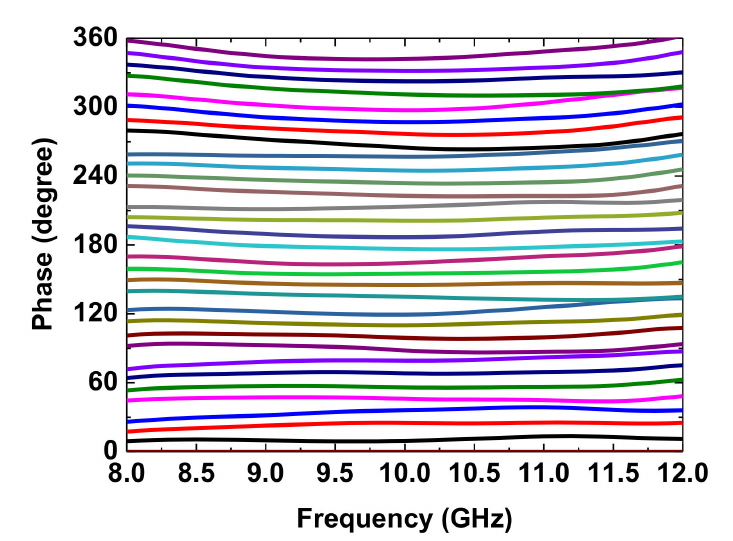
Figure 9. Measured relative phase of the phase shifter for all 32 states.